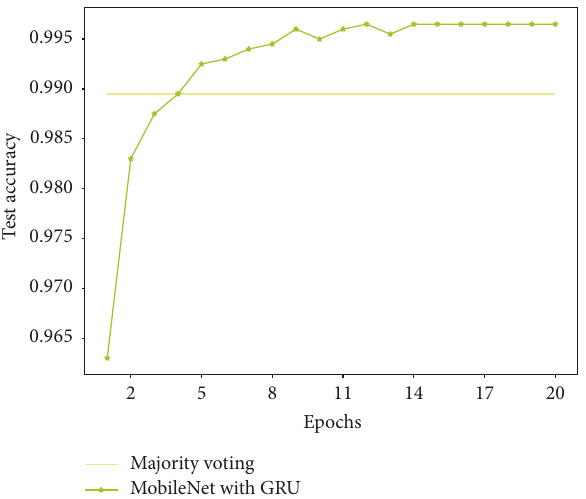
Figure 7: The test accuracy of C-RNN evolves as training advances.